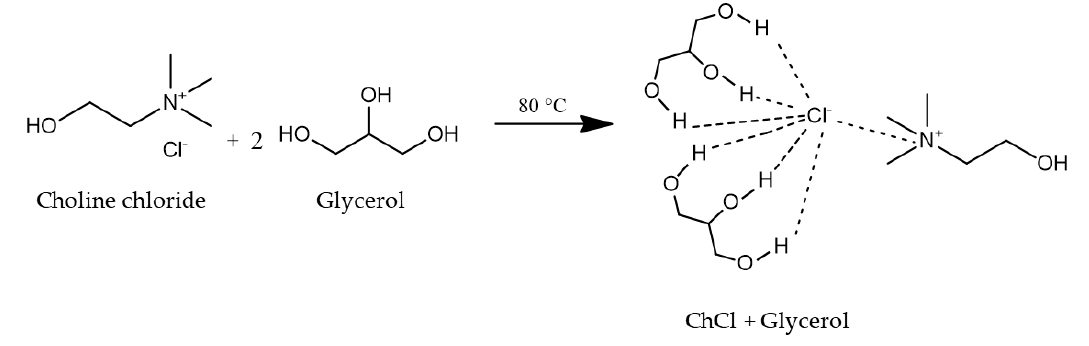
Figure 1. Chemical structure of choline chloride and glycerol [36].